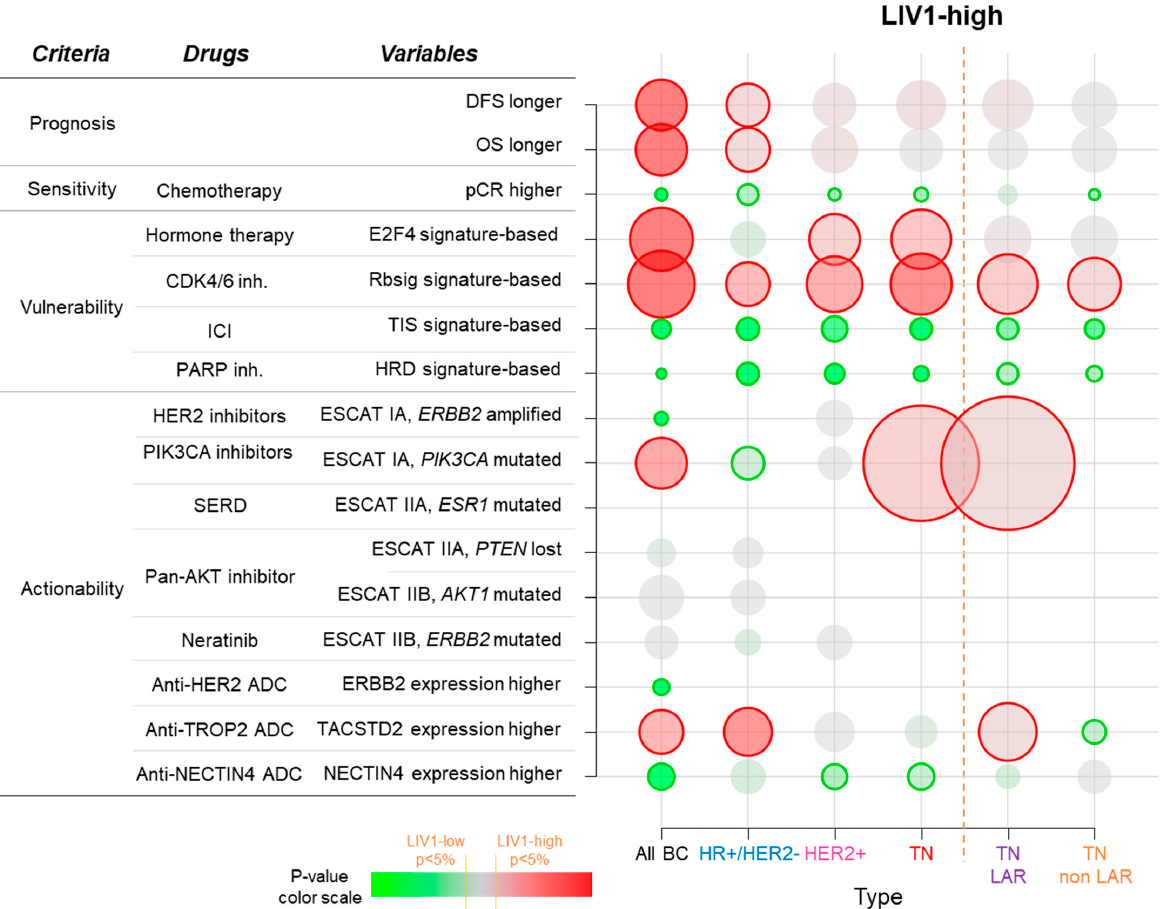
Figure 3. Correlations of LIV1 expression with clinical outcome and vulnerability/actionability to systemic treatments.